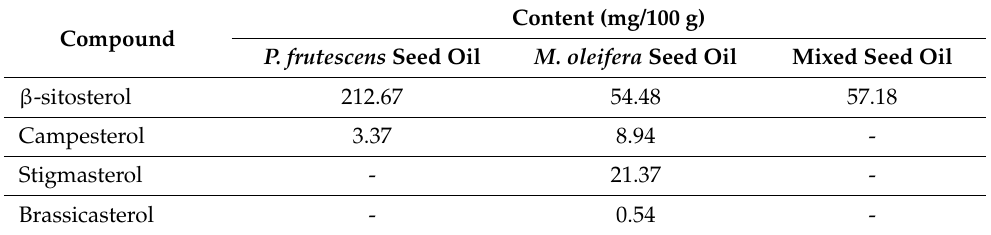
Table 1. Plant sterols in P. frutescens seed oil, M. oleifera seed oil, and mixed seed oil. Compound